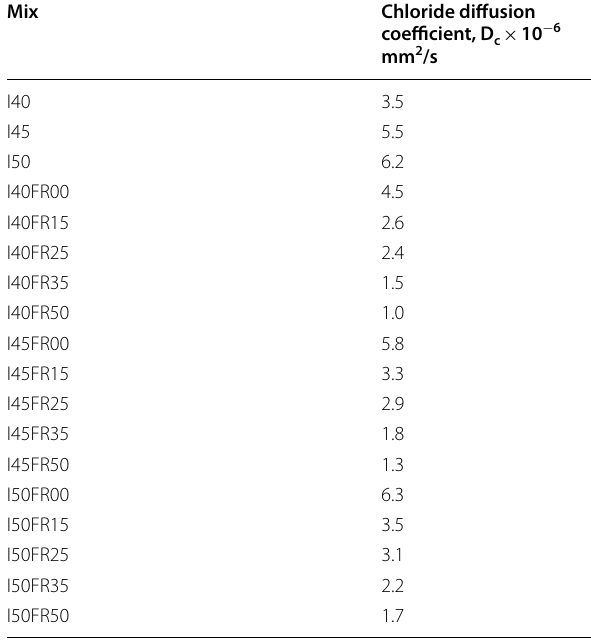
Table 5 D of NA concrete and RCA fly ash concretes after c being exposed to marine site for 7